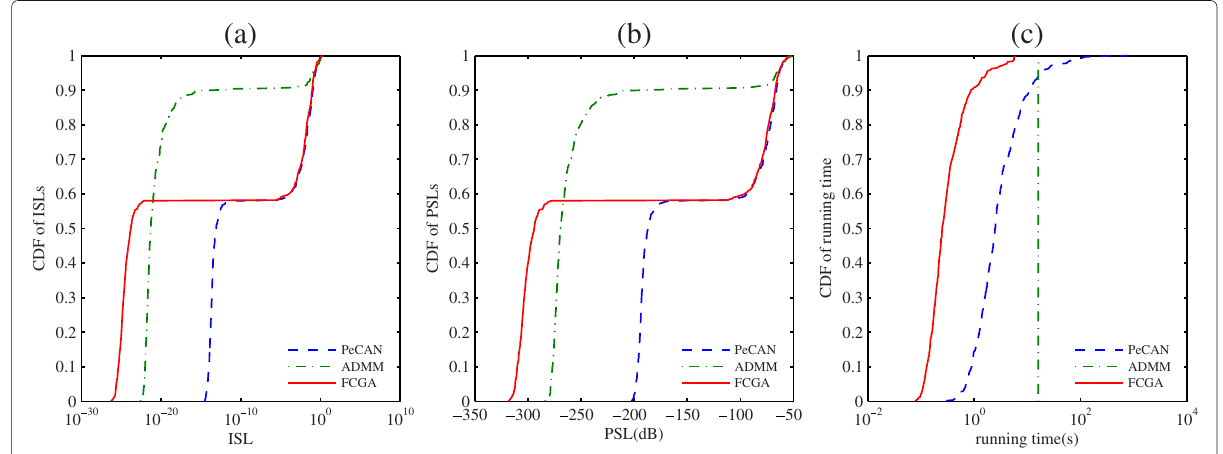
Fig. 4 The cumulative distribution functions of the a ISLs, b PSLs, and c running time